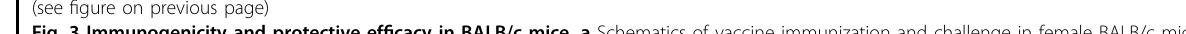
vaccinated, and one animal per group was immunized with a single dose of AdC6-S or AdC68-S vaccine can- didate, or prime-boost vaccine (AdC68-S + AdC6-S), respectively, with 2 × 10 10 vp via the intramuscular route.